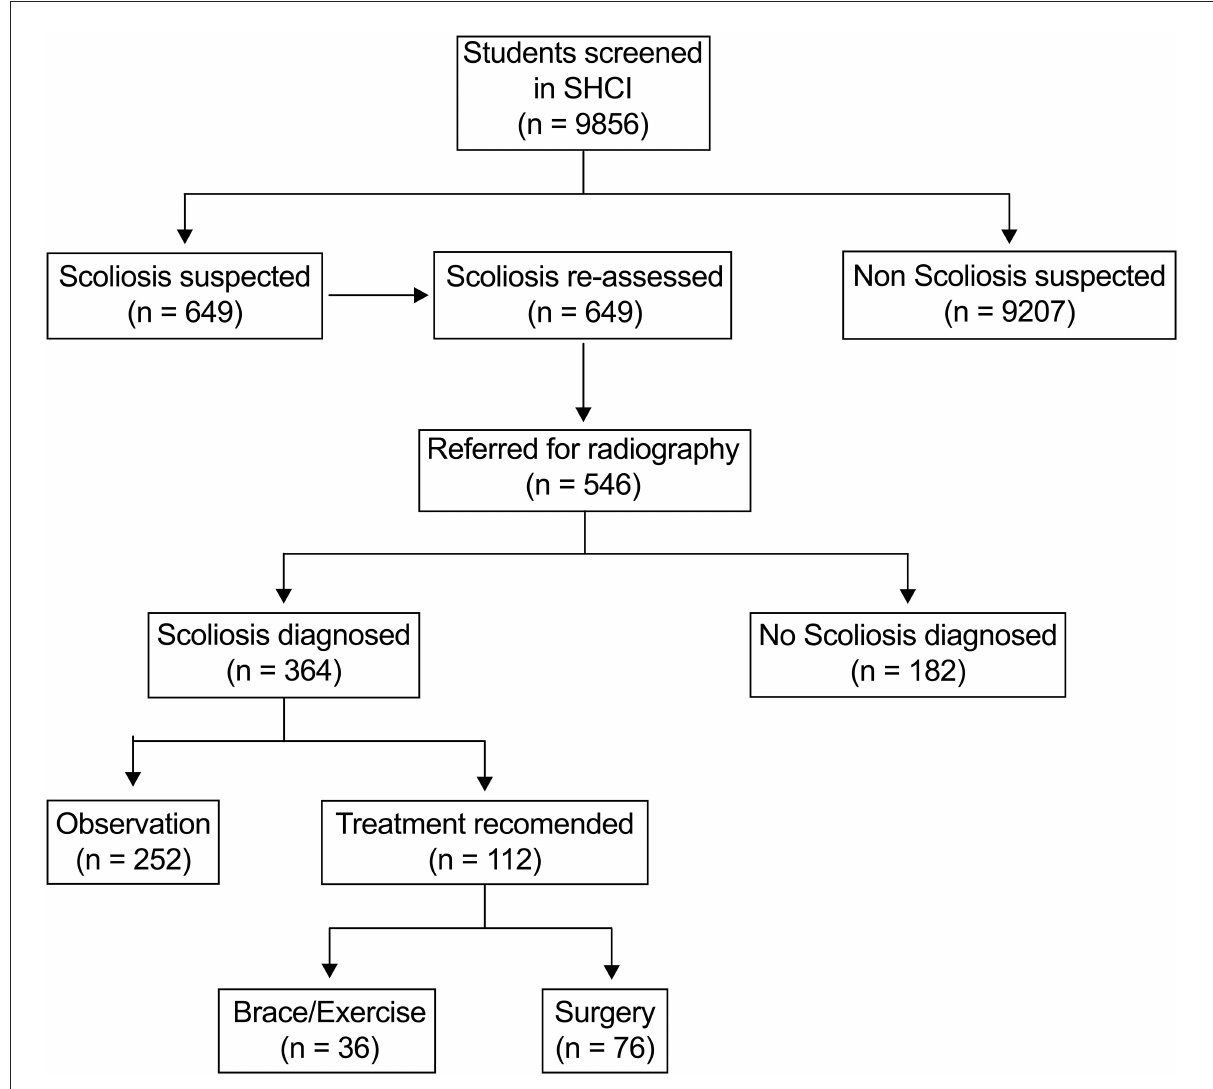
FIGURE1 Flowchart of the scoliosis screening program.